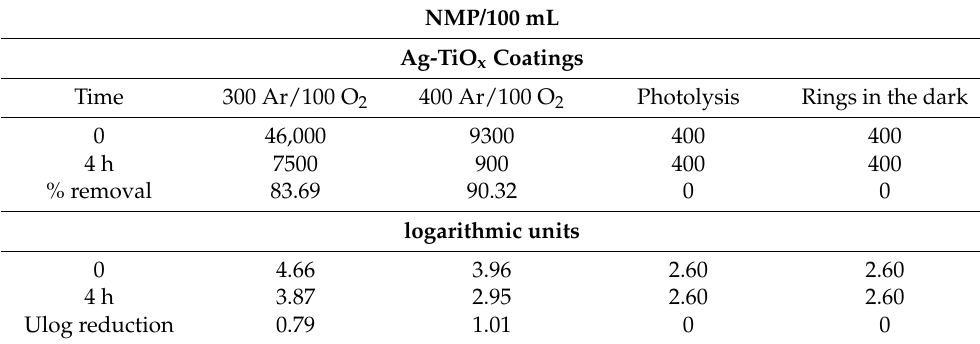
Table 6. Concentration of fecal coliforms in NMP/100 mL and Ulog in secondary effluent water from the GEA Ambiental plant using Ag-TiO x arc-PVD coatings on